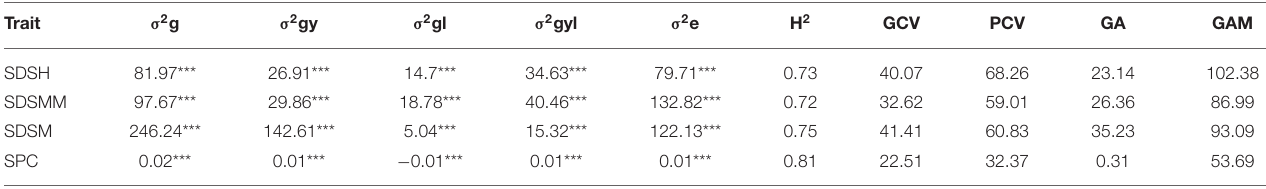
TABLE 4 | Variance component estimates for SDS, H 2 (broad sense), genotypic coefficient of variance (GCV), phenotypic coefficient of variance (PCV), genetic advance (GA), and genetic advance as percent of the mean (GAM) based on pooled data from the six environments. Trait